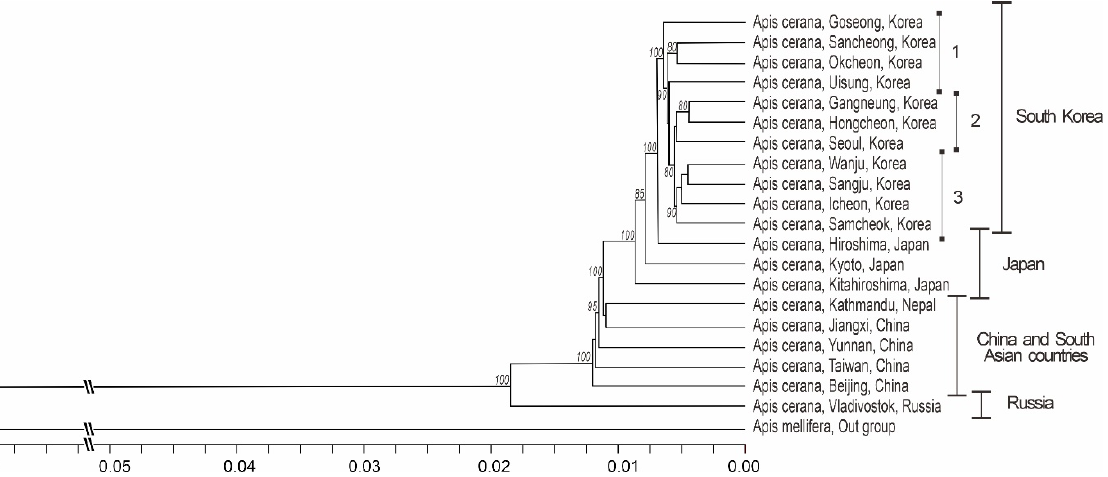
Figure 2. A neighbor-joining phylogenetic tree of A. cerana samples with outgroup A. mellifera based on the VG gene sequences. The Korean A. cerana populations subdivided into three groups according to their geographical distribution: 1. the southern provinces; 2. the northern provinces; and 3. the central provinces.